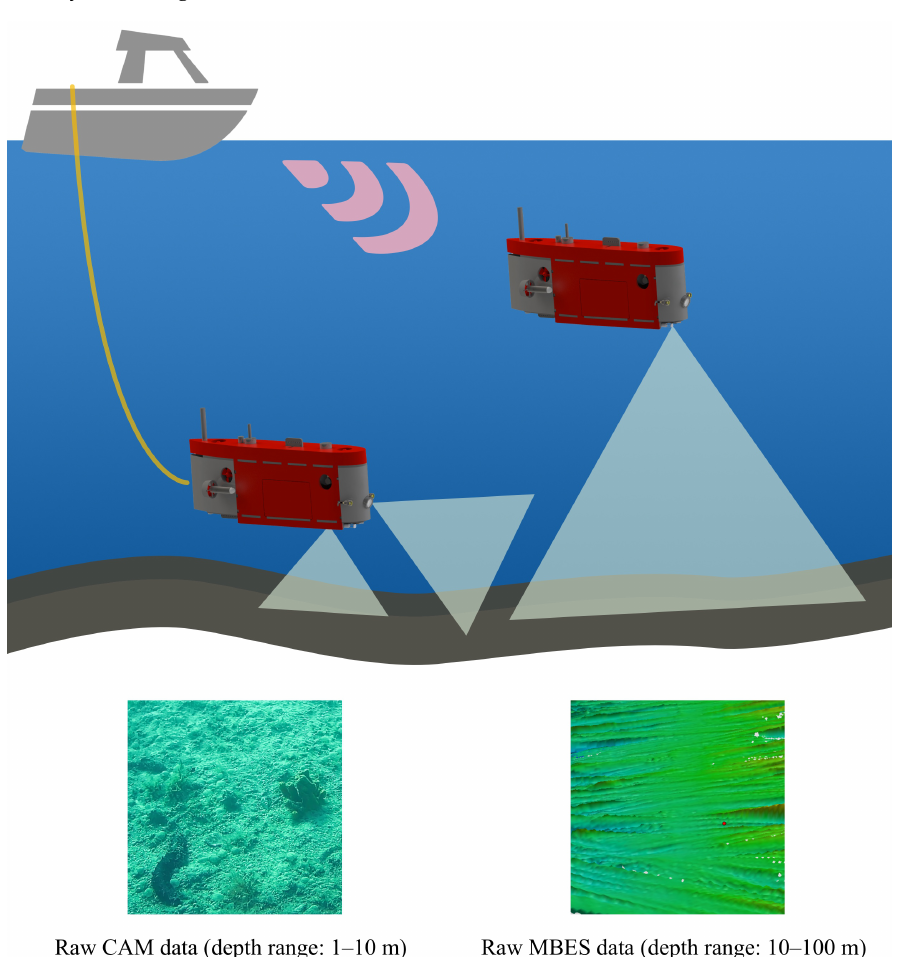
Figure 6. Graphical comparison between MBES in AUV mode and close seabed survey with Bottom- CAM and PilotCAM in ROV